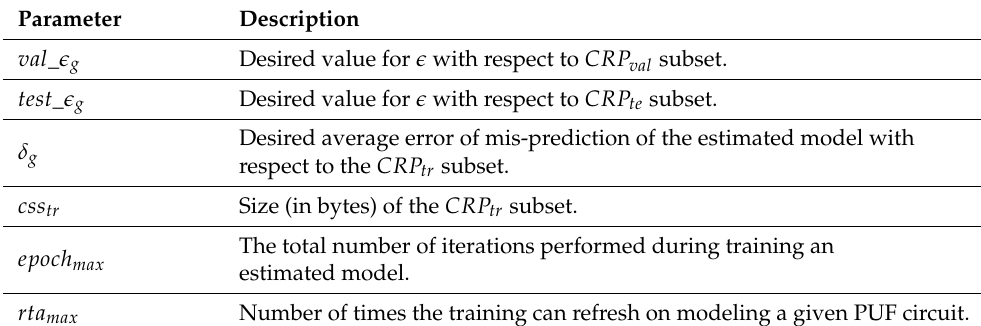
Table 1. Control parameters in the enrollment